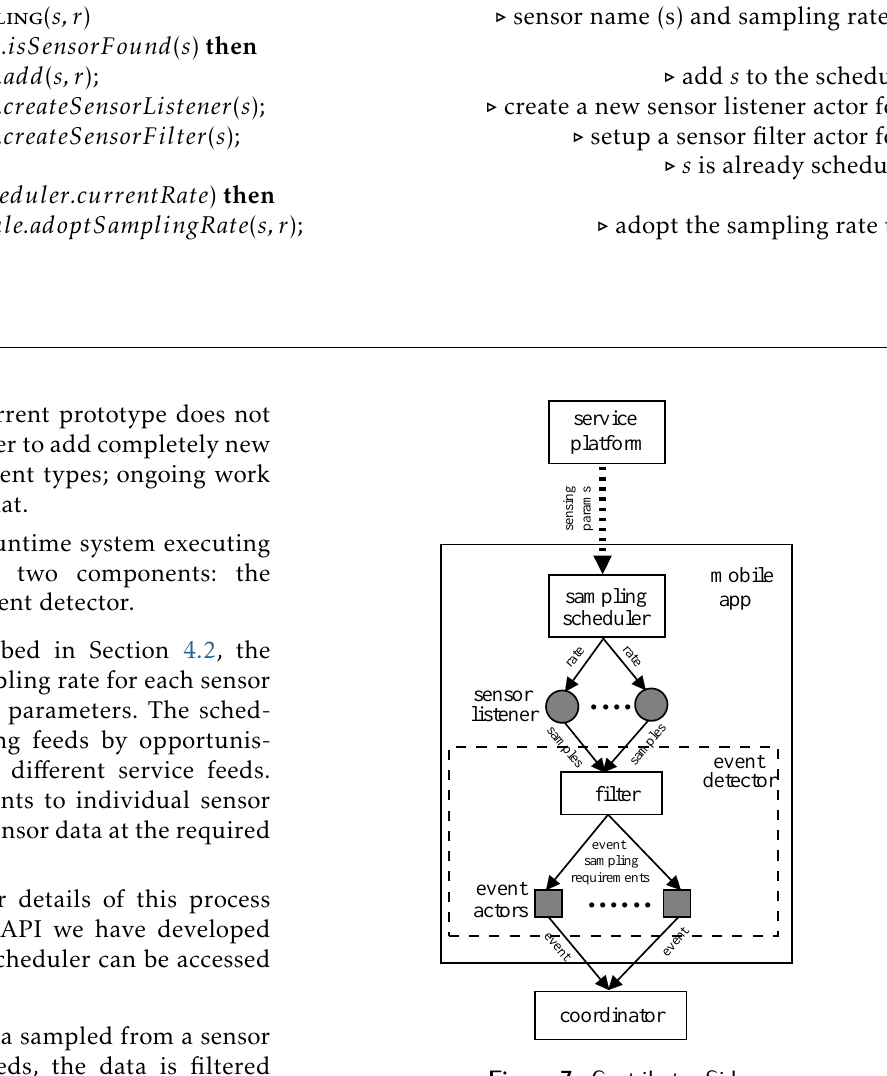
Figure 7. Contributor